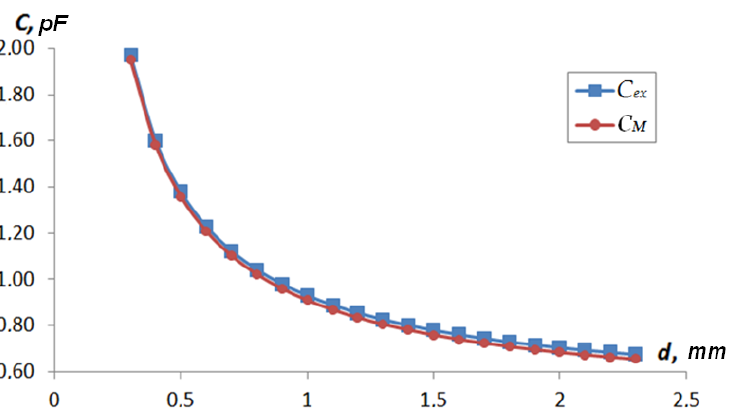
Figure 14. Comparison of experimental and model data for type 2 sensor.